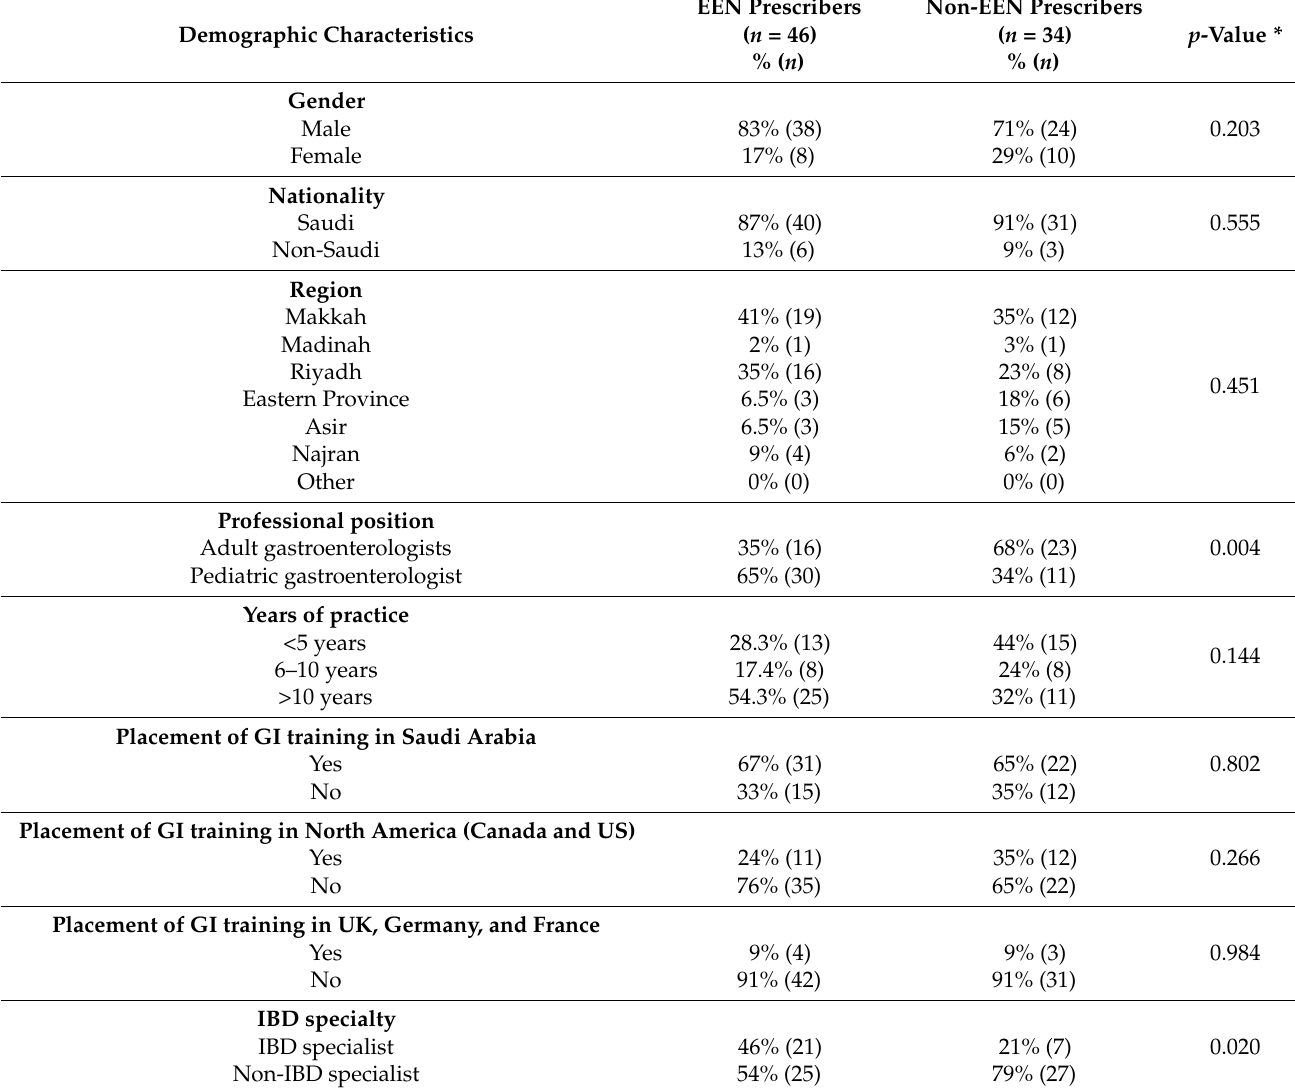
Table 3. Comparison between the demographic characteristics of EEN-prescribing and non-EEN- prescribing gastroenterologists ( n =